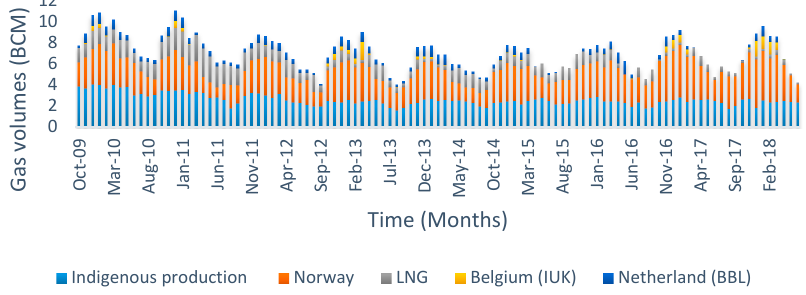
Figure2. MonthlygasimportstotheUKandindigenousproduction. Source: OFGEM–UK(Availableon Figure 2. Monthly gas imports to the UK and indigenous production. Source: OFGEM –UK (Available OFGEM website, https: // www.ofgem.gov.uk / data-portal / on OFGEM website, https://www.ofgem.gov.uk/data-portal/gas-demand-and-supply-source-month- gb).